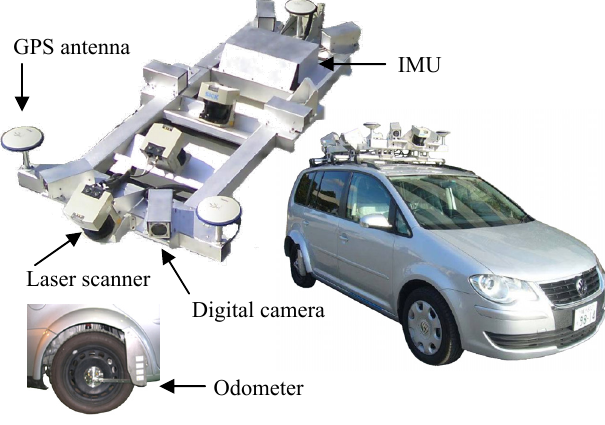
Figure 1. System configuration of MMS